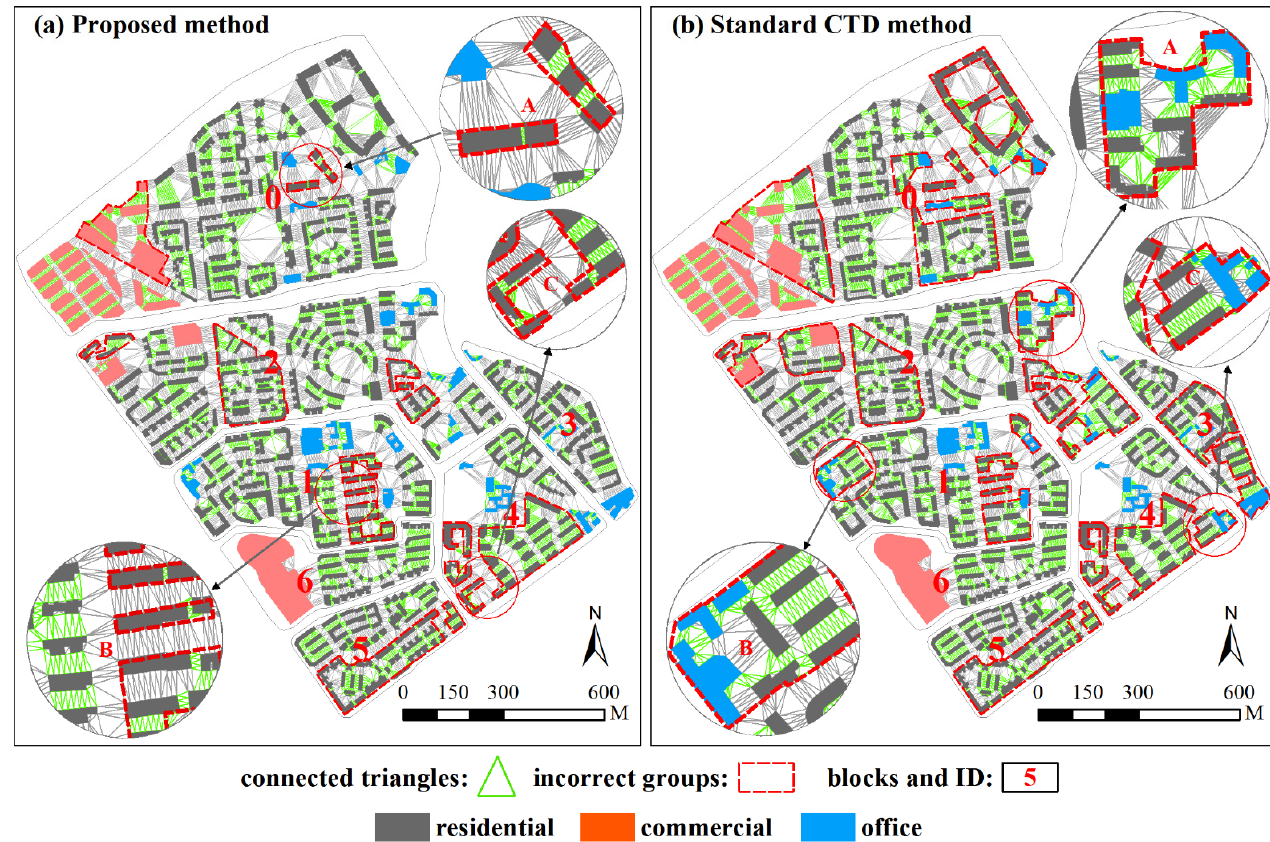
Figure 9. The remaining triangles during the segmentation procedure (step 6) are shown for ( a ) the proposed method, and ( b ) the standard CTD method. Buildings within the red outlines indicate misclassified building groups.